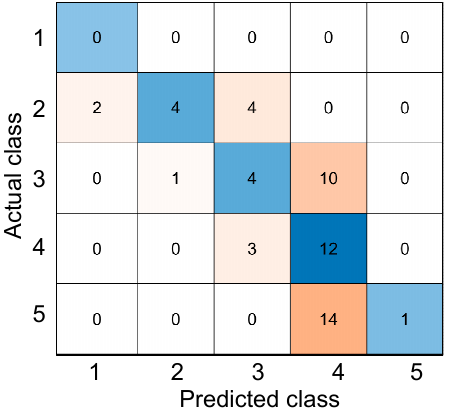
Figure 11. Confusion matrix from classifying the temperatures derived from the regression equations used from coherence values.